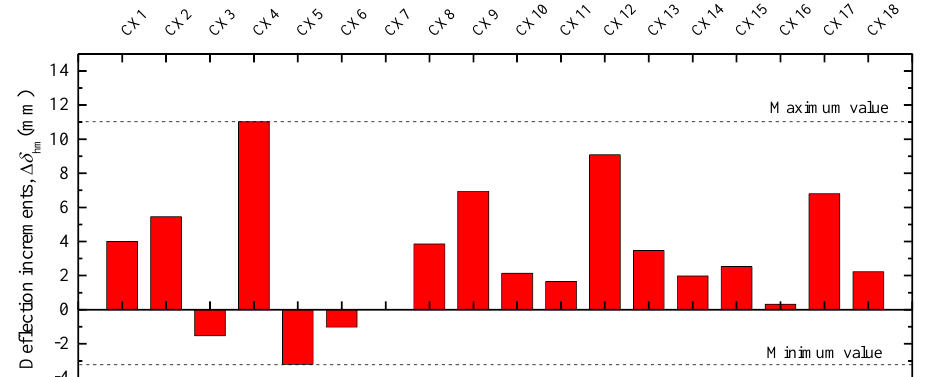
Figure 8. Maximum wall defection increments after the completion of base slabs.